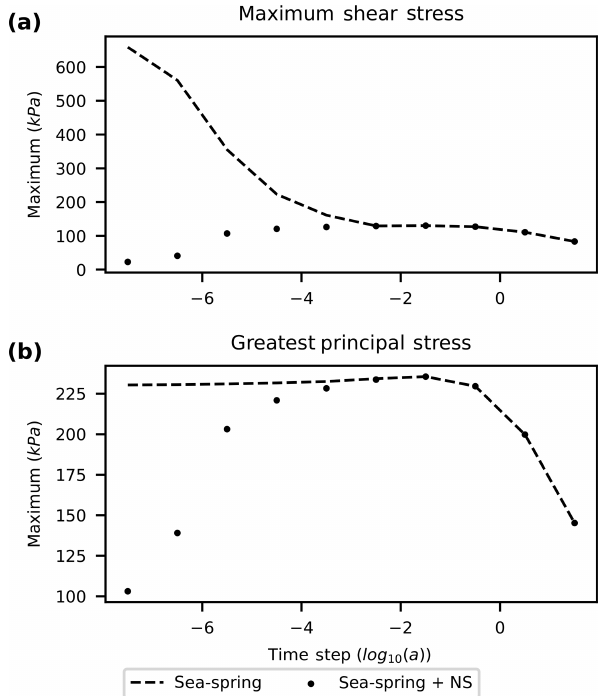
Figure 3. Maximum (a) maximum shear stress and (b) greatest principal stress immediately after the emulated calving event. The maximum is calculated based on cell-averaged values. Solutions af- ter a single time step are shown for sea-spring damping and sea- spring with Navier–Stokes (NS) for time step size ranging from 1s to 30 years. Without corrections, maximum stress is overestimated in the Stokes model, which could lead to overestimation of glacier retreat due to